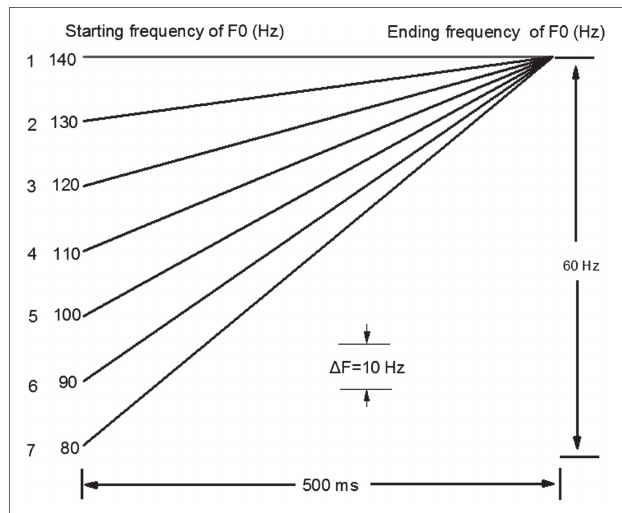
FIGURE 1 | Schematic diagram of the Tone 1-2